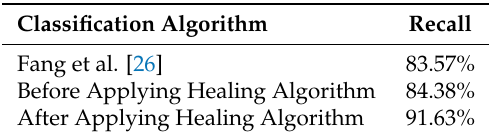
Table 8. Performances of the proposed method and